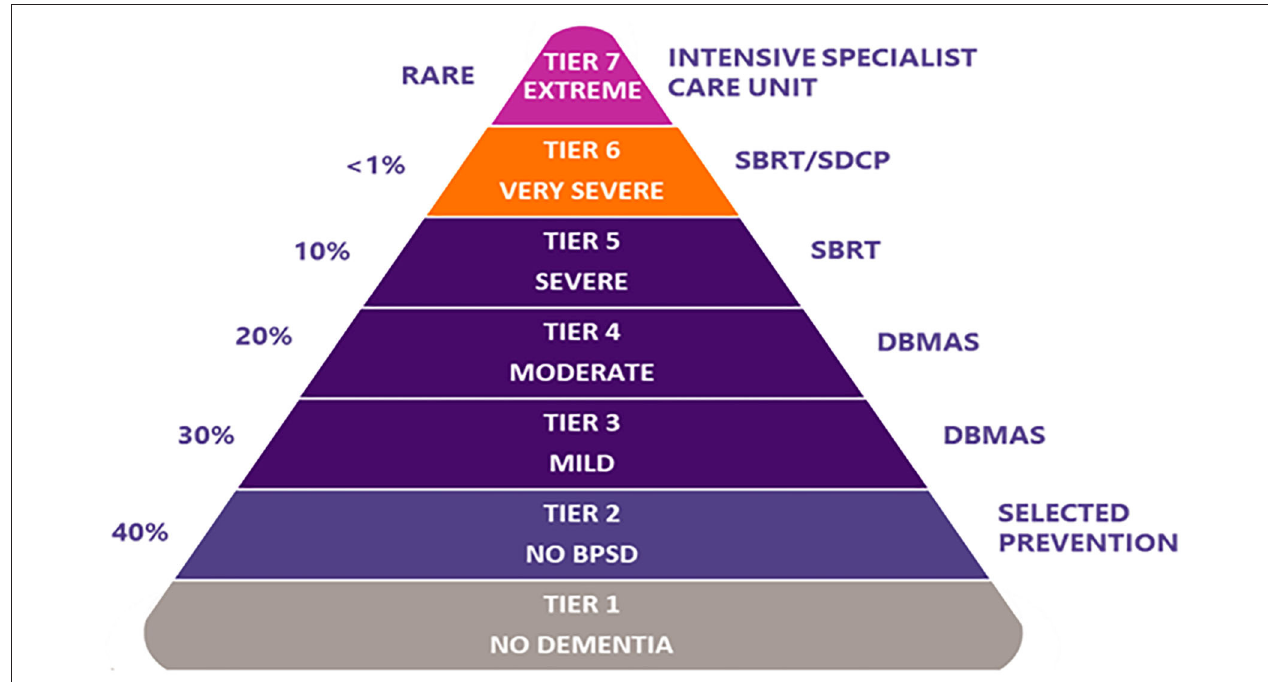
FIGURE 1 | The seven-tiered dementia care model of service delivery, as per Brodaty et al. (20). % on the left represents estimated prevalence for each corresponding tier. BPSD, behaviours and psychological symptoms of dementia; DBMAS, Dementia Behaviour Management Advisory Service; SBRT, Severe Behaviour Response Teams; SDCP, Specialist Dementia Care